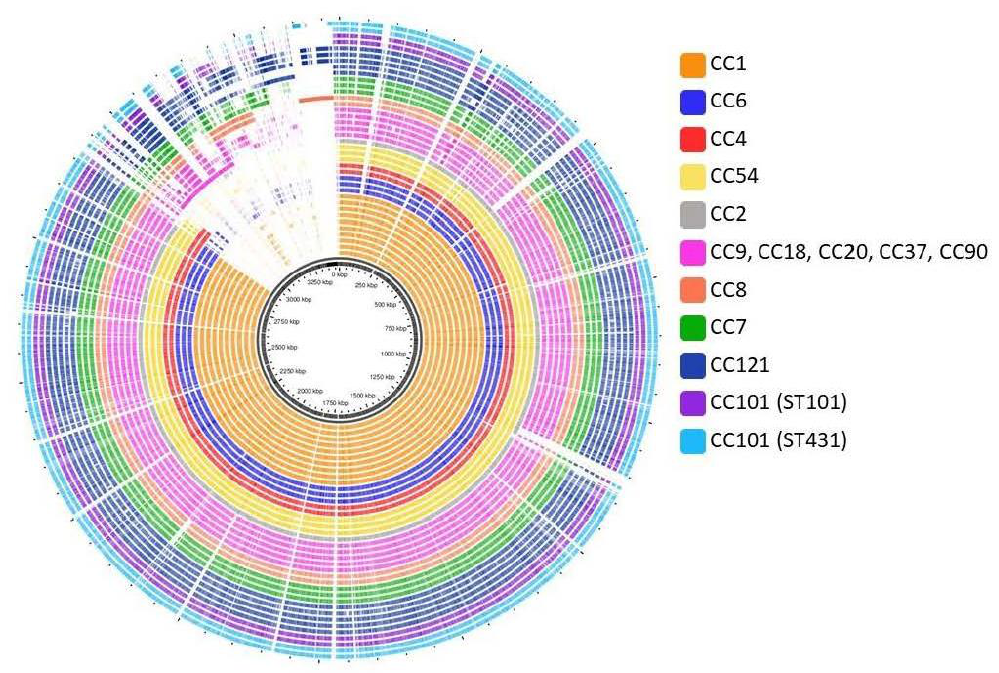
Figure 3. Pan-genome, constructed using GView [35], of 34 genomes including 25 clinical isolates, six food-associated isolates and three reference genomes. The pangenome is constructed by iteratively appending unique regions onto the initial seed genome in this case F2365. Gaps indicate that the region is missing in a particular gene but is found in others. Strains are grouped according to CC and colour coded as indicated.